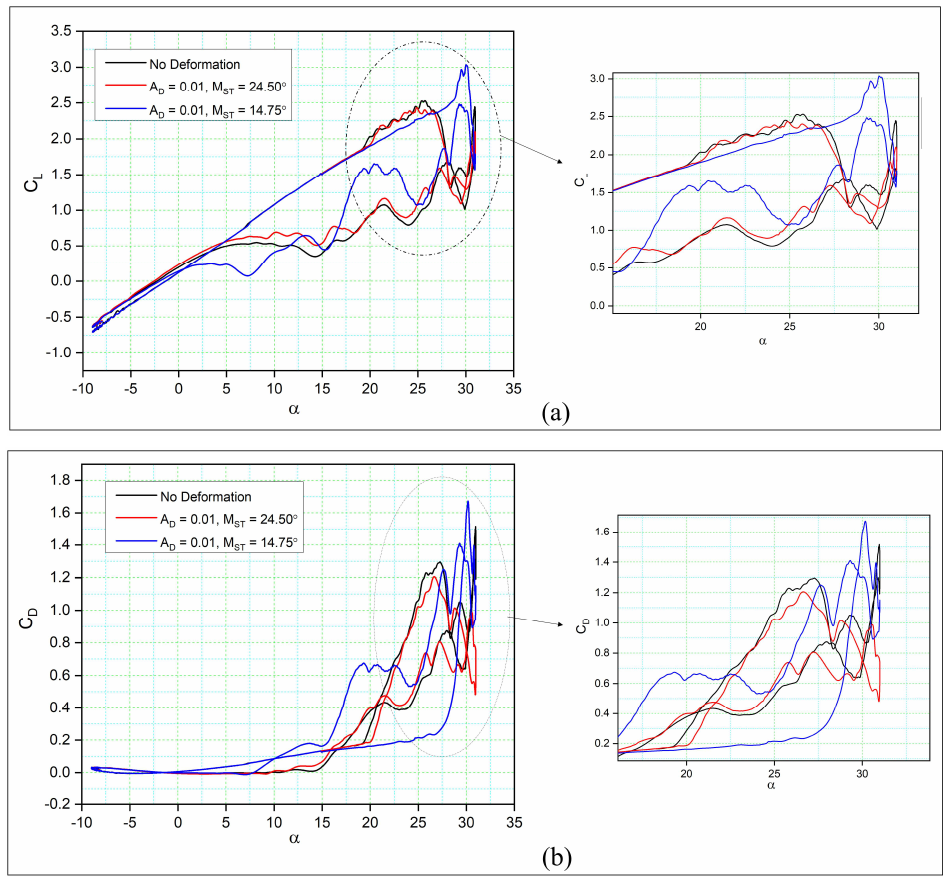
Figure 8. Hysteresis cycles for ( a ) the lift coefficient of DMLE airfoils and ( b ) the drag coefficient of DMLE airfoils in comparison to the reference (no deformation) airfoil.